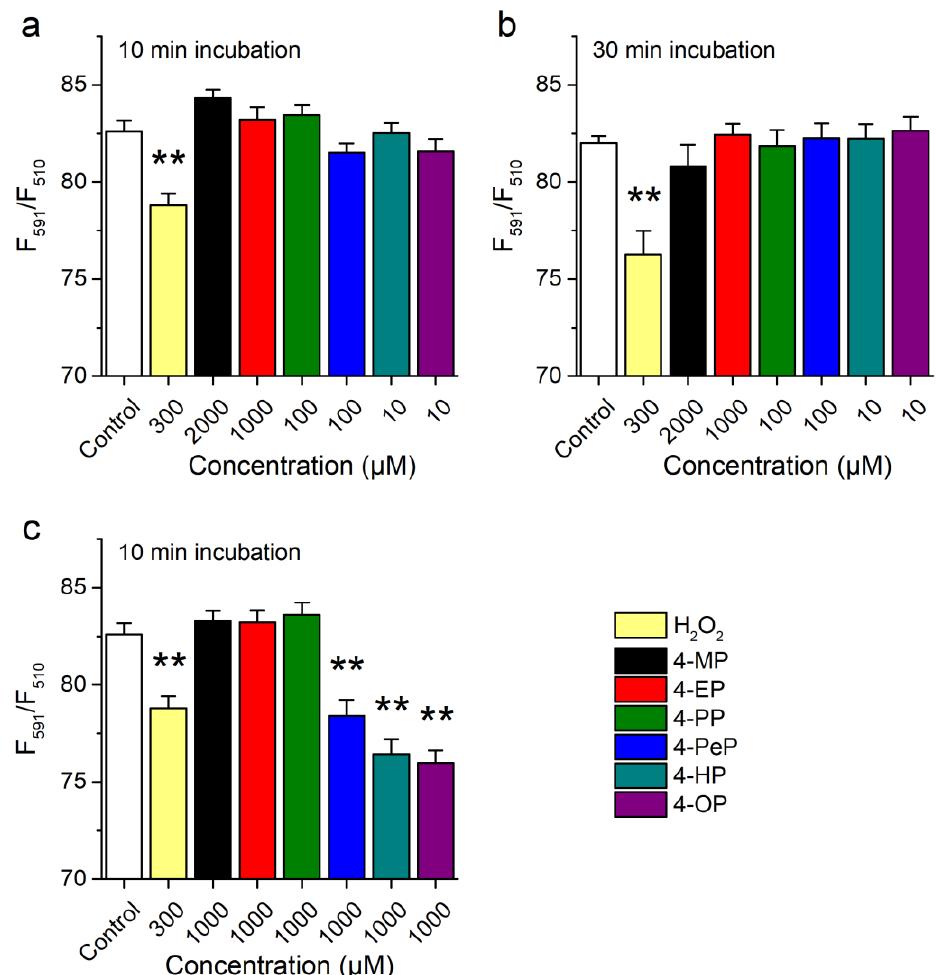
Figure 3. Alkylphenols do not induce lipid peroxidation at concentrations inducing mTRPA1 activation. ( a , b ) Ratiometric assessment of lipid peroxidation after 10 min ( a ) and 30 min ( b ) treatment with 4-MP (2000 µ M), 4-EP (1000 µ M), 4-PP (100 µ M), 4-PeP (100 µ M), 4-HP (10 µ M), 4-OP (10 µ M) or 300 µ M H 2 O 2 . ( c ) Comparison of the effect induced by APs at a concentration of 1000 µ M. Data is presented as mean ± s.e.m. from three experiments (** p < 0.01, two-tailed Mann-Whitney U test).